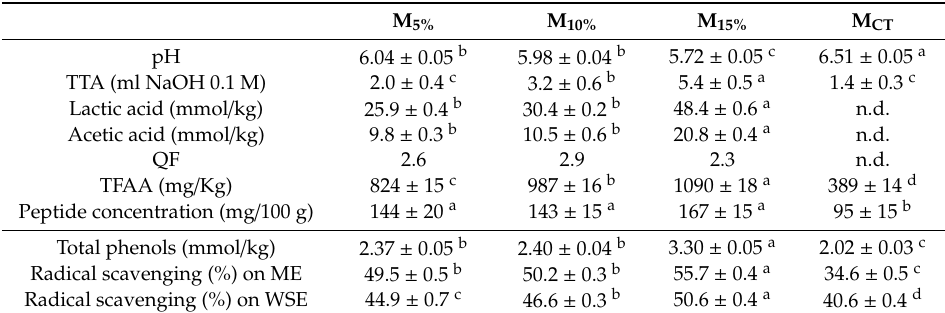
Table 2. Biochemical characteristics and antioxidant activity of the te ff mu ffi ns: M 5% , mu ffi n containing 5% (wt / wt) type-I sourdough; M 10% , mu ffi n containing 10% (wt / wt) type-I sourdough; M 15% , mu ffi